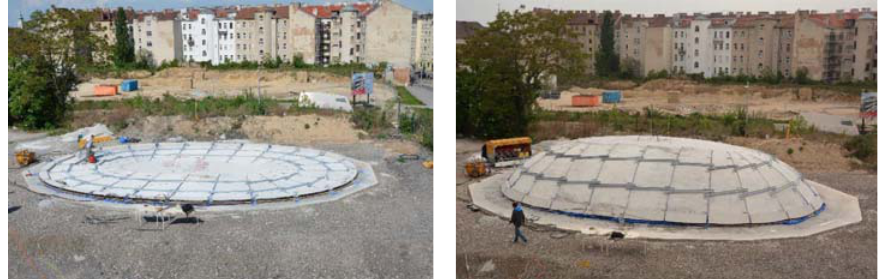
Figure 23: Large-scale experiment in Austria: erection of a free-form concrete shell using PFHC